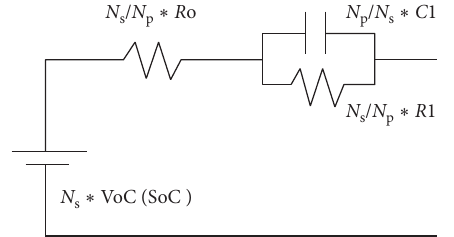
Figure 4: Equivalent circuit model of a lithium-ion pack battery.